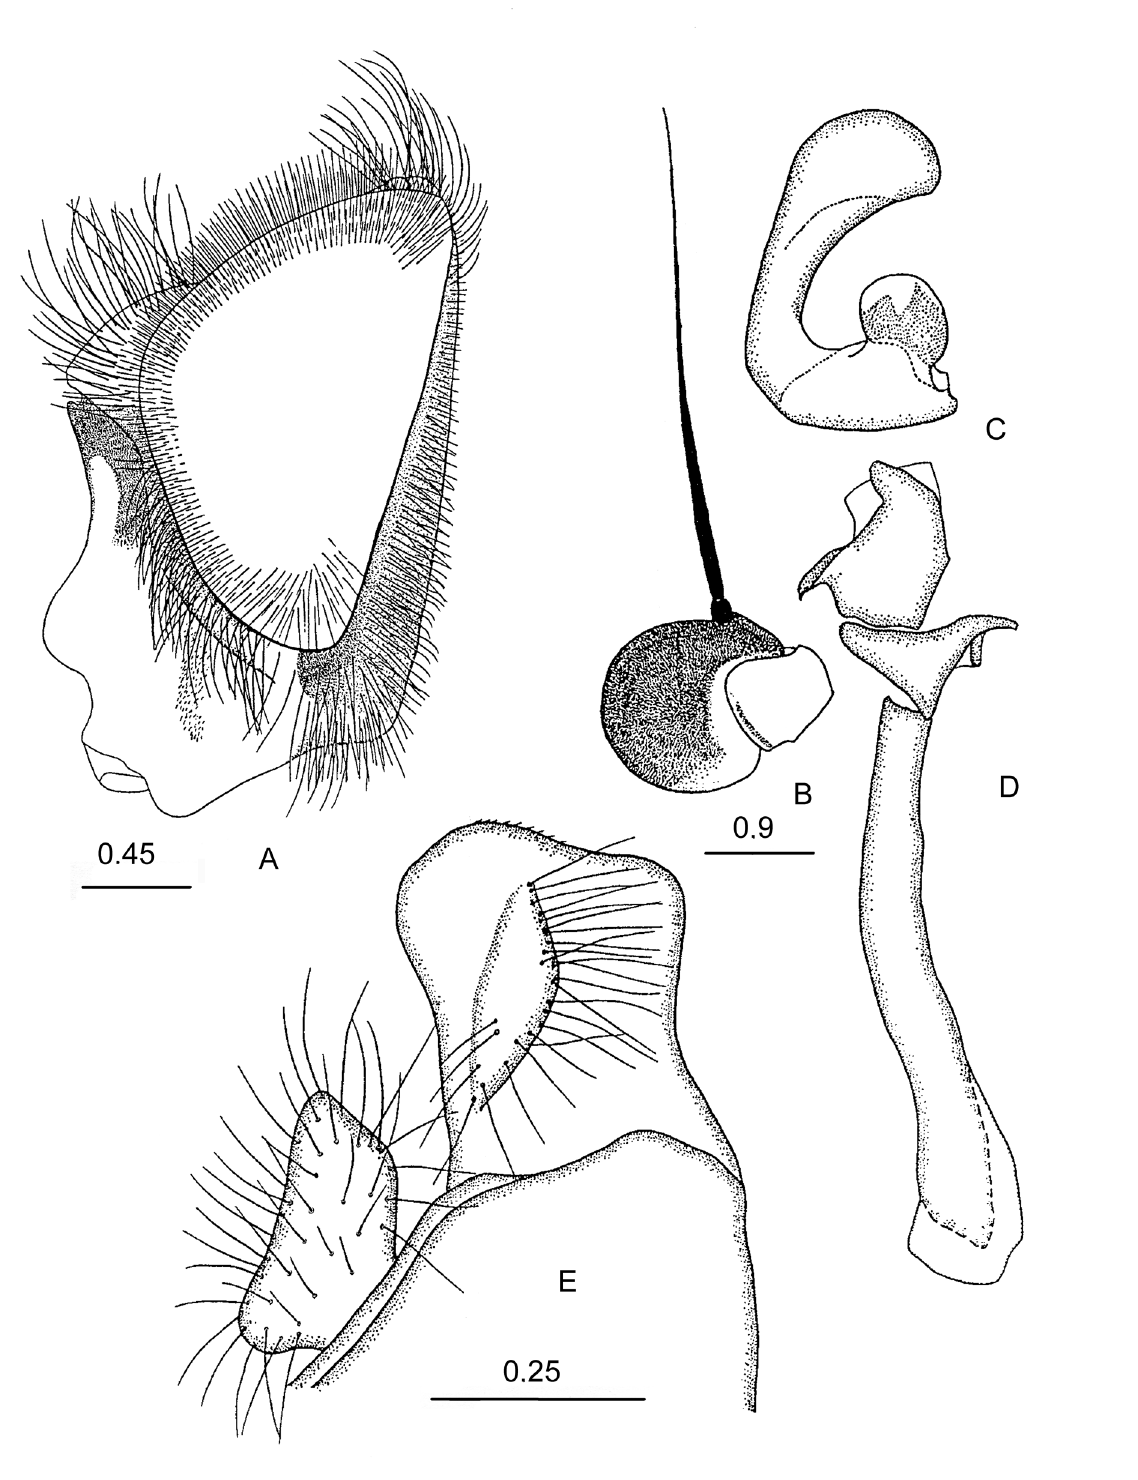
Fig. 18. Cheilosia ( Montanocheila ) erratica Barkalov & Peck, 1997, ♂. A . Head, lateral view. B . Antenna, lateral view of pedicel and basoflagellomere. C . Superior lobe of hypandrium, lateral view. D . Aedeagus and aedeagal apodeme, lateral view. E . Surstylus and gonocercus, lateral view. After Barkalov & Peck 1997. Scale bars indicated in